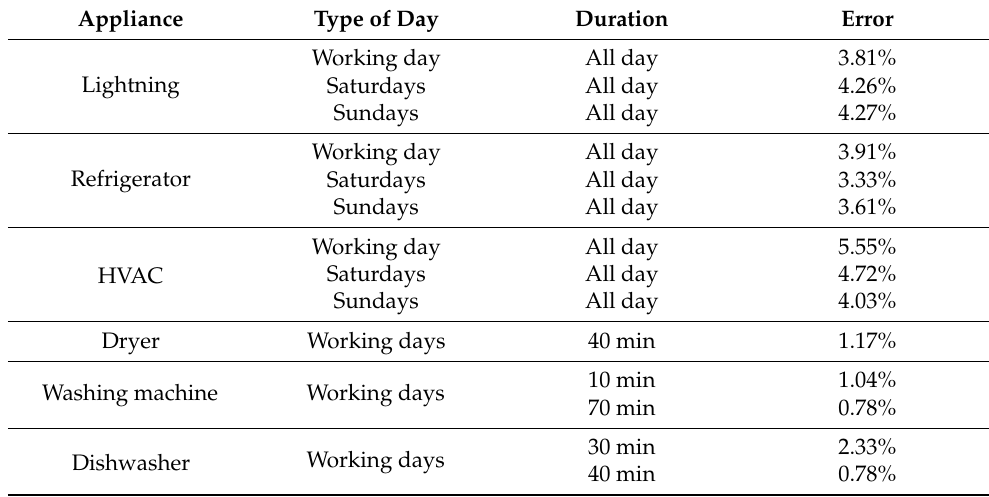
Table 4. Summary of the error